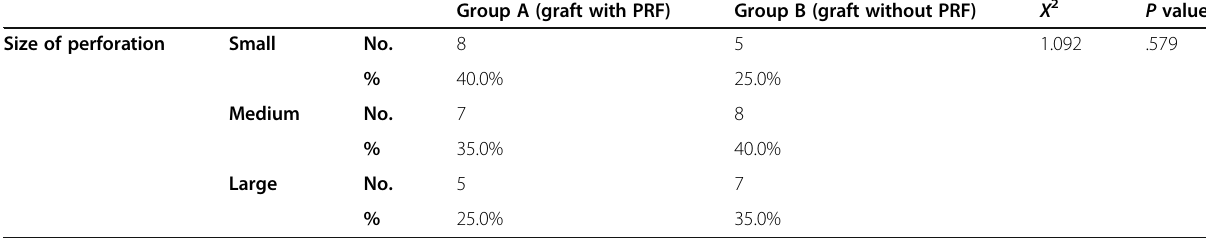
Table 2 Comparison between group A and group B regarding the size of perforation Group A (graft with PRF)